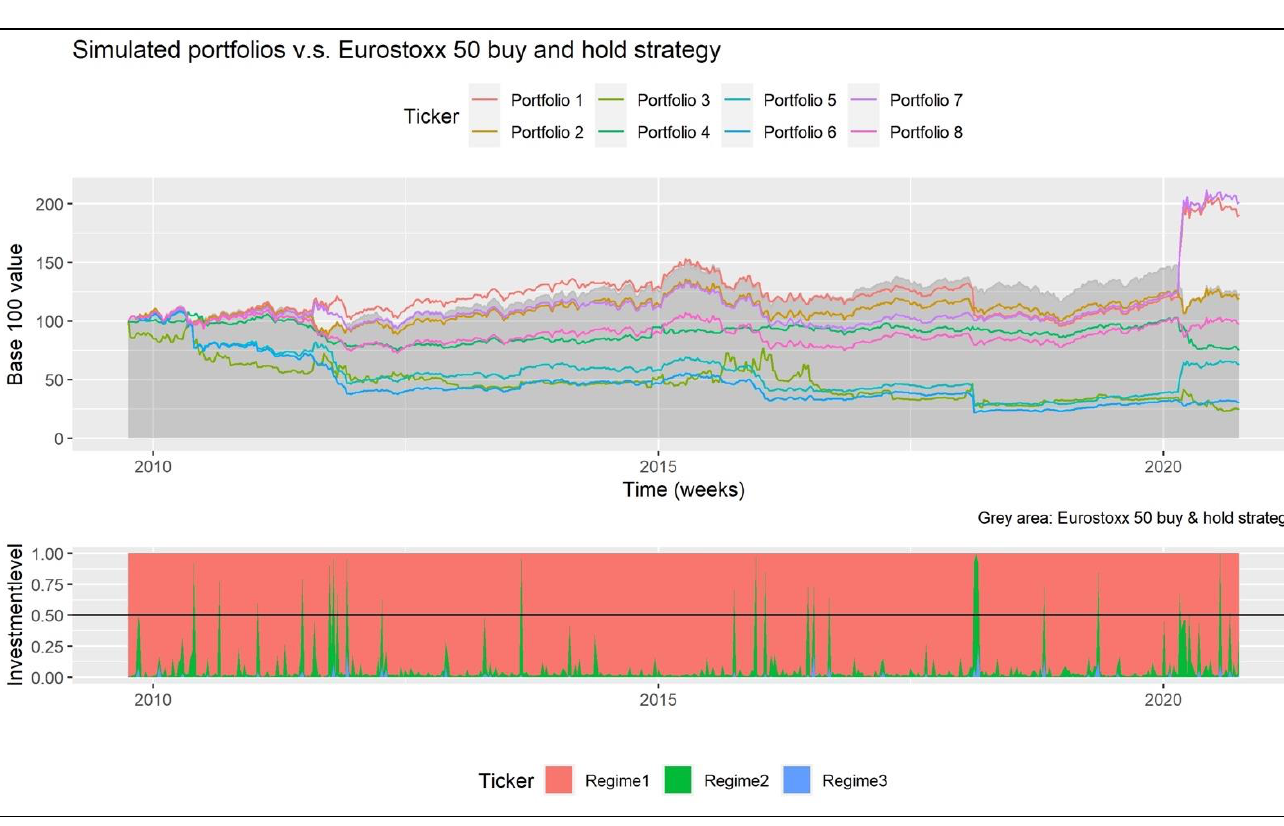
Figure 5. Weekly historical performance of the eight simulated portfolios of Table 2 with smoothed ( ω i = ξ s = i , T + 1 ) weighting method. It presents the historical 9 July 2009 Base 100 value of the eight simulated portfolios (lines) against a buy-and-hold ESTOXX50 strategy (grey area). The historical three-regime MS-GARCH regime-specific forecasted smoothed probabilities ( ξ s = i , T + 1, t ). Methodological note: The eight simulated portfolios include the impact of a stock-trading fee of 0.1% plus 10% VAT.